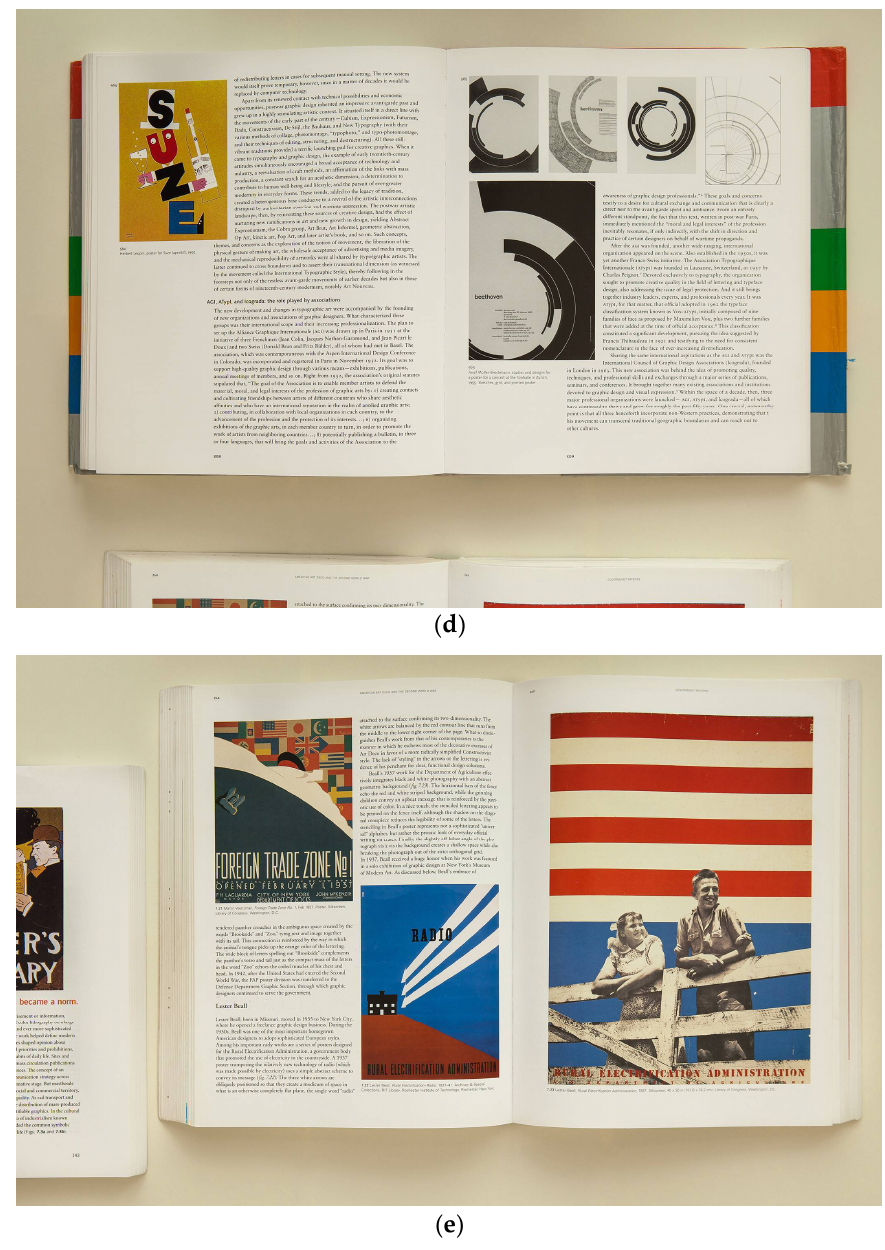
Figure 2. ( a ) Herbert Spencer, Pioneers of Modern Typography , revised edition, 1983. Spencer chose to reproduce the artefacts (taken mostly from avant-garde magazines and books) as black-and-white or black-and-red line art, and all reference to the page format is removed. The resulting reproductions are extremely distant from the original items and suggest the idea of abstract graphic elements instead of physical objects [10]; ( b ) Daniele Baroni & Maurizio Vitta, Storia del design grafico . 2003. This spread presents a selection of posters and covers by Herbert Matter. The size of the images does not correspond to the kind of object, and the images are quite similar in the use of colour, composition and typography [11]; ( c ) Philip B. Meggs & Alston W. Purvis, Meggs’ history of graphic design , 4th edition, 2006. In this example magazine covers and spreads designed by Alexey Brodovich and Alexander Lieberman are presented in the same size as two posters by Joseph Binder [12]; ( d ) Roxanne Jubert, Typography and Graphic Design: From Antiquity to the Present , 2006. A well known poster by Josef Müller Brockmann is accompanied by several sketches, reproduced at a smaller scale. Showing sketches and other behind-the-scenes documentation can be a way to highlight the design process [13]; ( e ) Stephen J. Eskilsson, Graphic Design: A New History , 2007. Given the dimensions of the book (21.5 × 29.2 cm), the poster by Lester Beall on the right-hand page is reproduced at an impressive size, which is reminiscent of the layout of an art catalogue